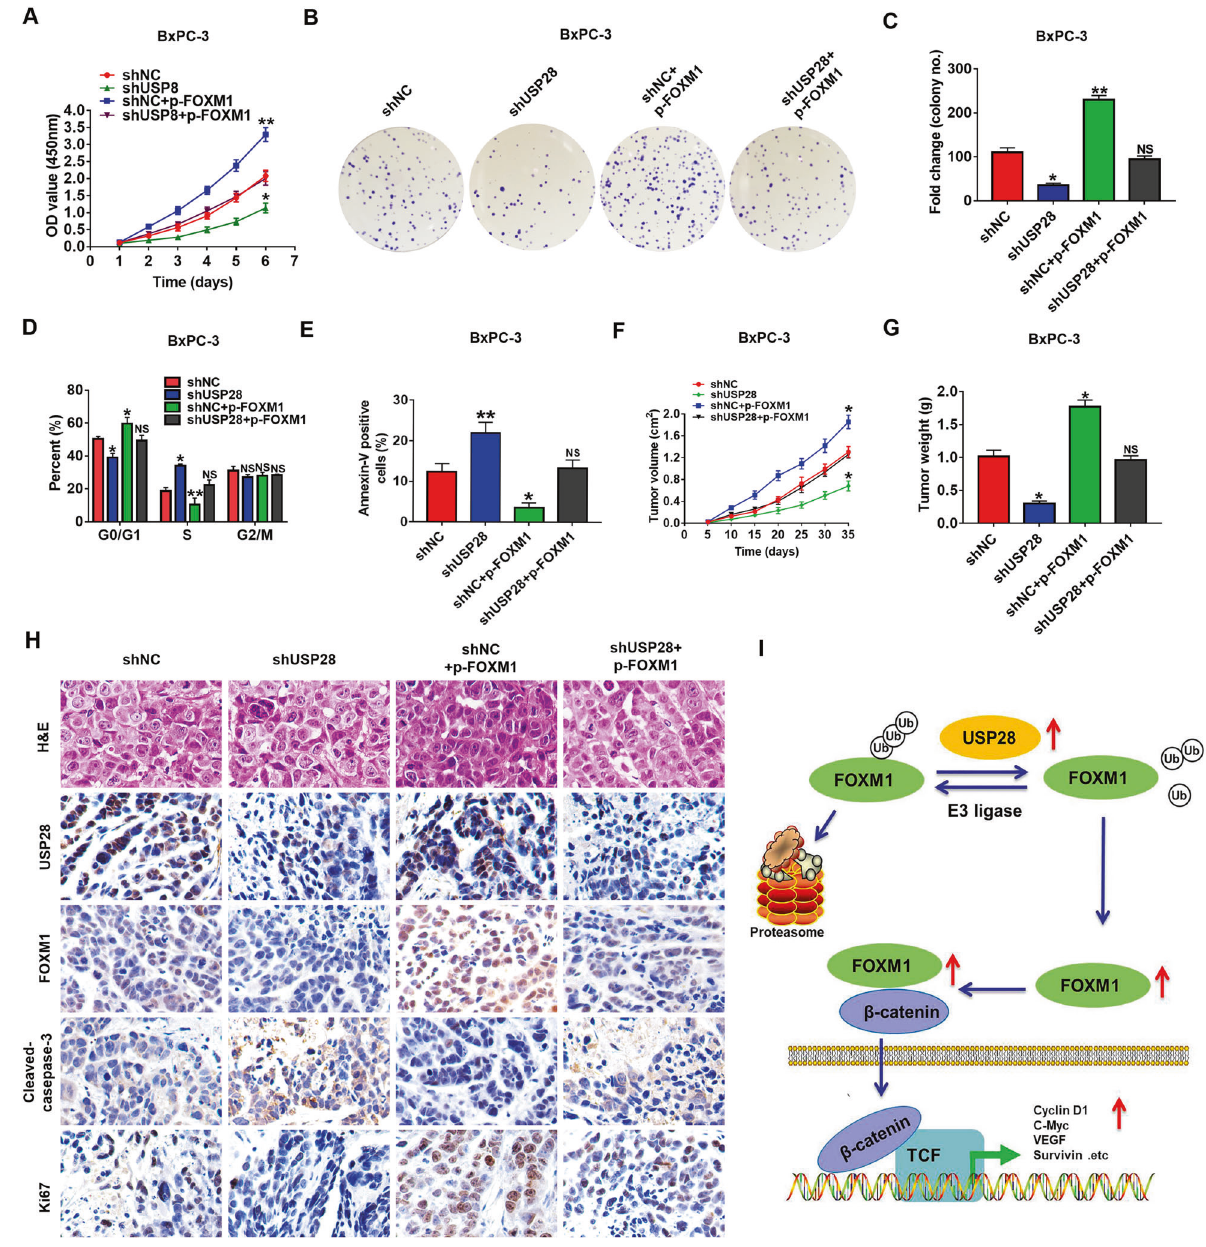
Fig. 7 Oncogenic effect of USP28 is dependent on FOXM1 stabilisation. A – C Restoration of FOXM1 expression impaired the anti-tumour effect caused by USP28 knockdown, as determined by CCK-8 ( A ) and colony formation assay ( B and C ) in AsPC-1 cells. D , E The quanti fi cation of cell cycle ( D ) or cell apoptosis ( E ) assay in the different groups. The data represent mean ± SD from three independent experiments and were statistically analysed with Student ’ s t test, * P < 0.05, ** P < 0.01. F , G The quanti fi cation of tumour volume ( F ) or tumour weight ( G ) assay in the different groups. * P < 0.05. H Representative H&E and IHC staining of USP28, FOXM1, Cleaved-caspase-3 and Ki67 in tumour tissues isolated from different nude mice groups. Scale bar, 50 μ m. I Proposed mechanistic scheme of USP28 in promoting the FOXM1-mediated Wnt/ β -catenin signalling pathway in pancreatic